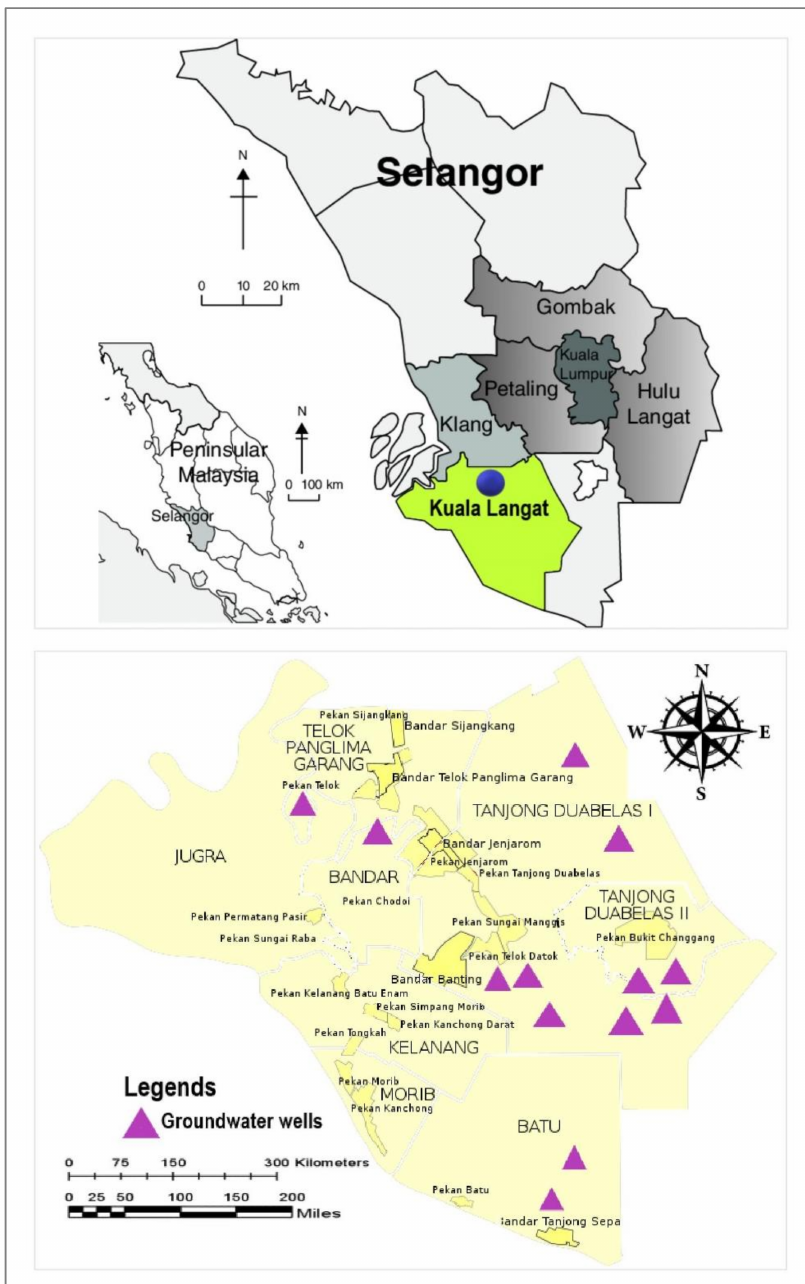
Figure 1. The sampling stations of groundwater wells in Kuala